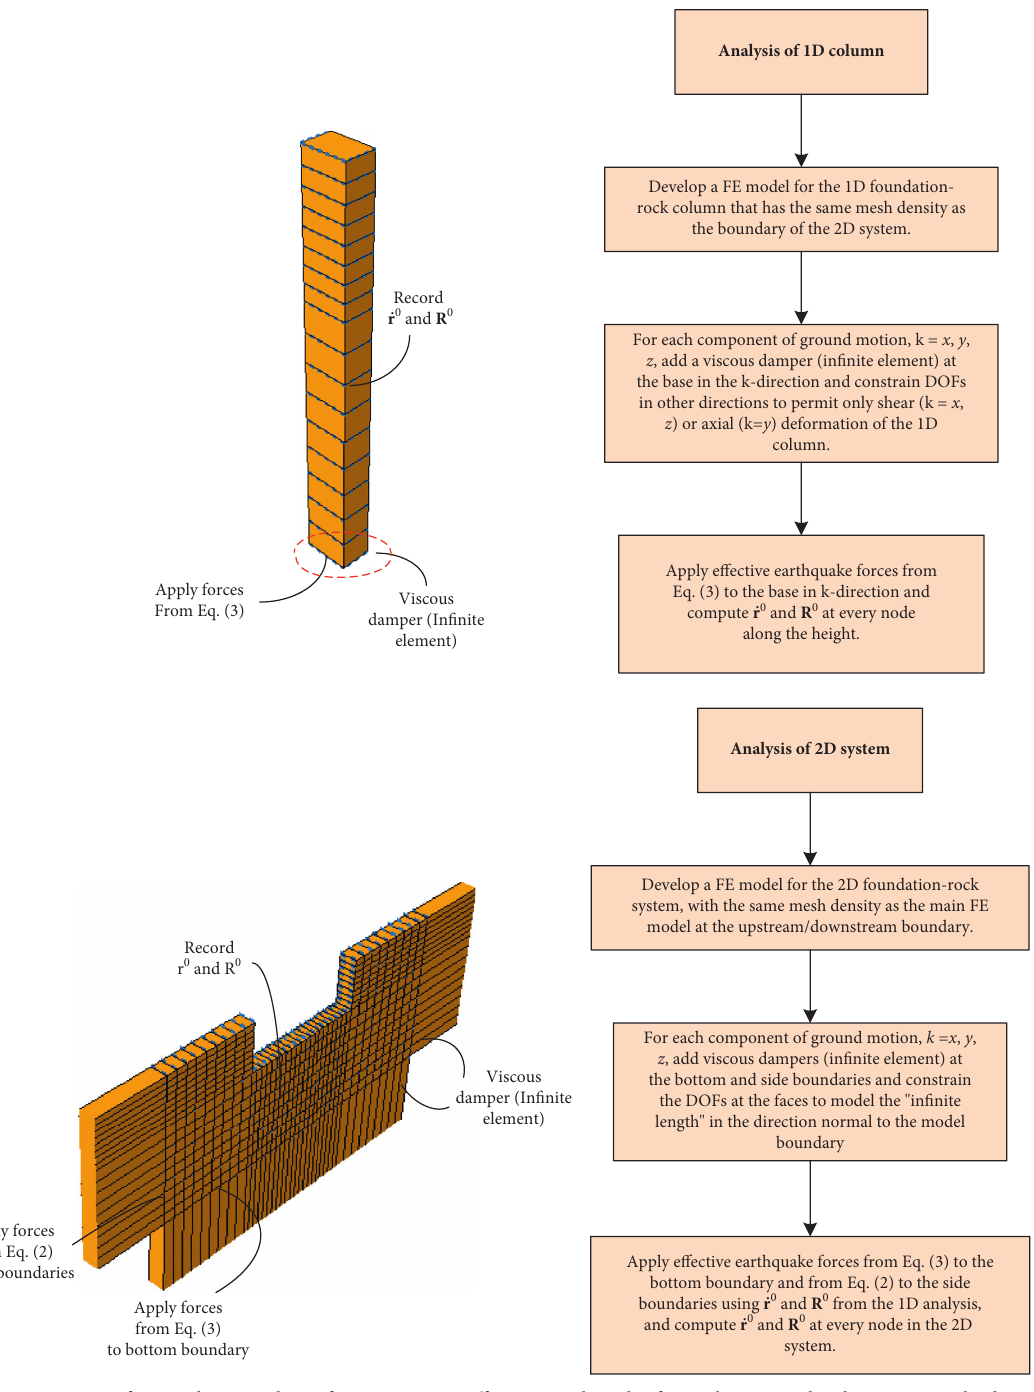
Figure 5: Steps for auxiliary analyses for computing effective earthquake forces by using the direct FE